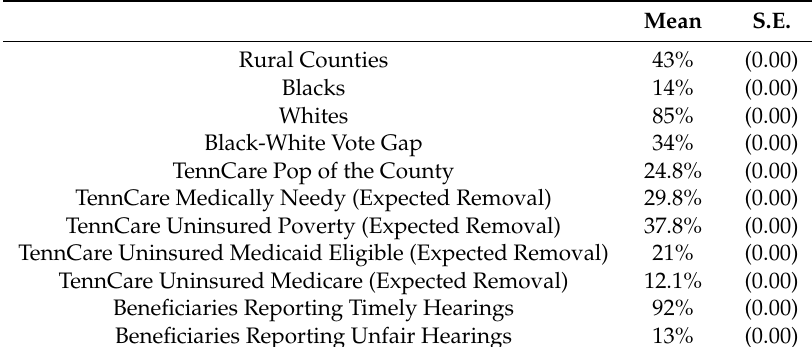
Table 1. Select Characteristics of TennCare Appellants.